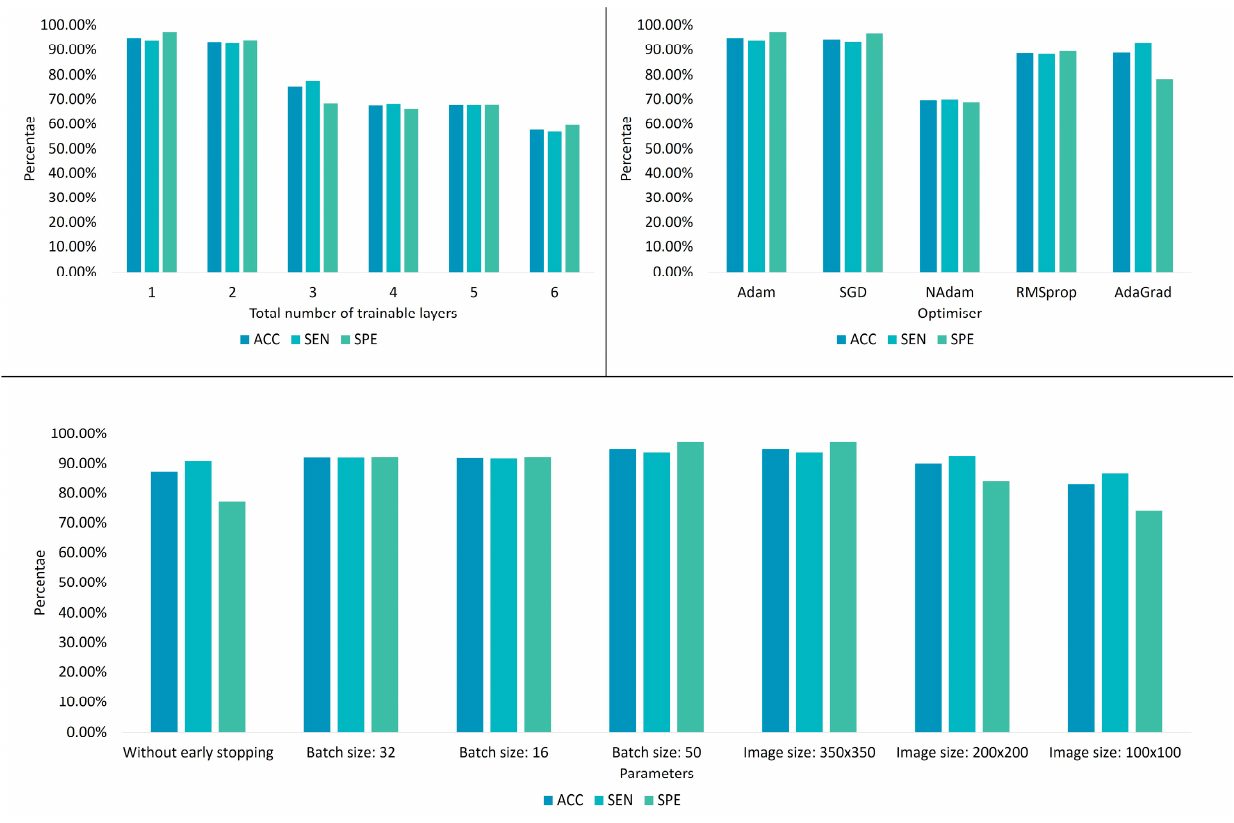
Figure 8. ParaNet parameter tuning results. Table 7. The accuracy of ParaNet variations in distinguishing between normal and abnormal scans when altering the total number of trainable convolutional layers.